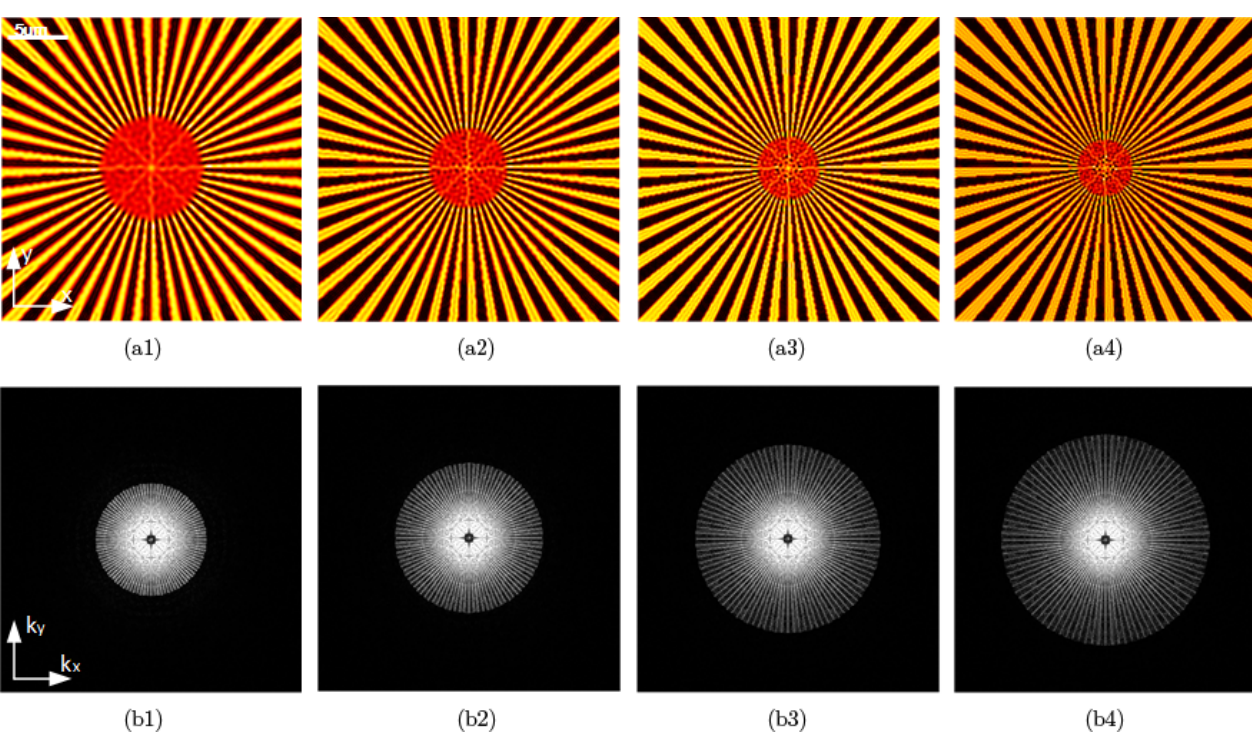
Fig. 2. FPM recovery using di®erent NA of OL1. (a) Simulated results of a spoke-like sample with di®erent NA of OL1, the NAs are (a1) 0.7, (a2) 1, (a3) 1.3, and (a4) 1.49, respectively. (b) The corresponding spatial spectra of (a). The scale bar is 5 (cid:1)